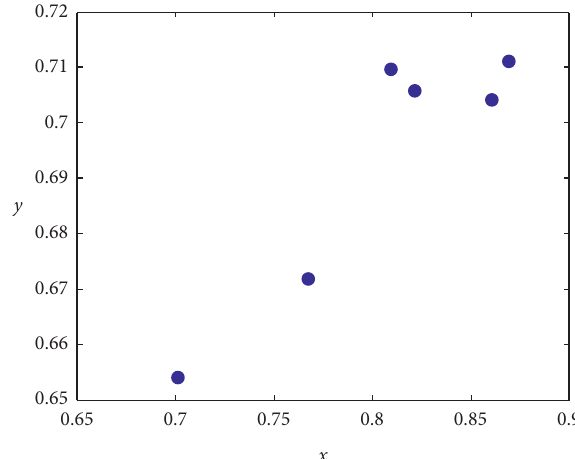
Figure 5: x – n sequence diagram which denotes that the system is chaotic when α � 2.